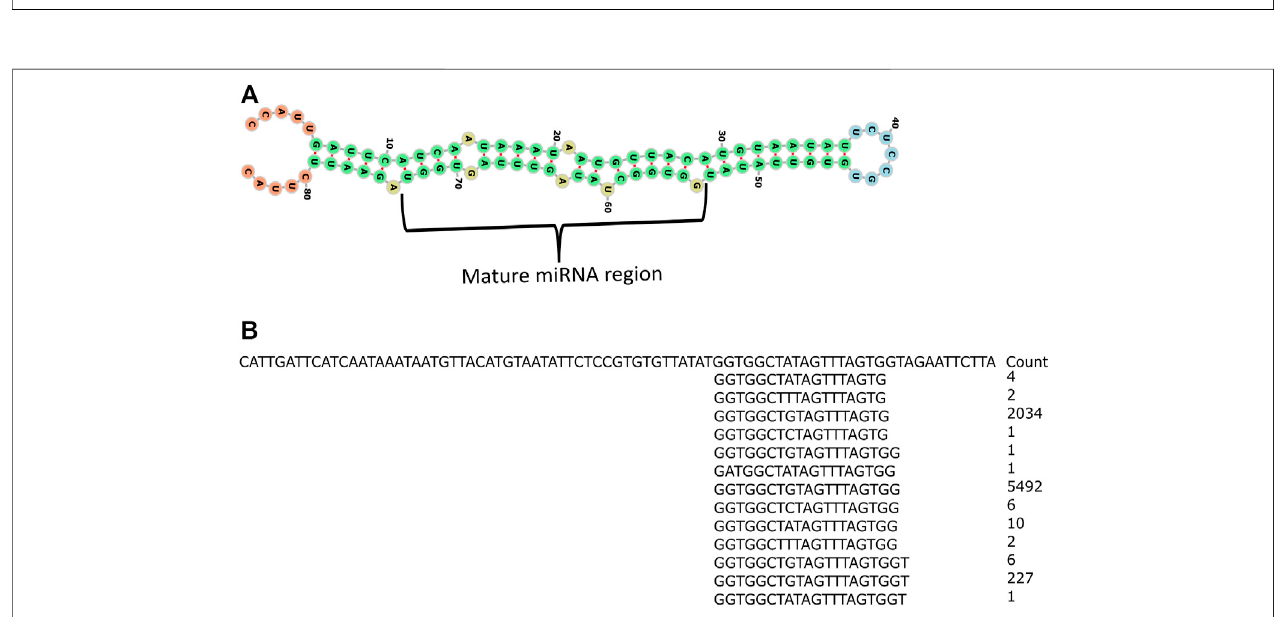
FIGURE 6 | Secondary structure of the NmiR1 precursor sequence and read alignment. (A) RNA fold predicted possible minimum energy secondary structure of the NmiR1 precursor sequence with perfect alignment of the mature miRNA region to its star miRNA. (B) Read alignment of 24 hpi third biological replicate sequencing data with read